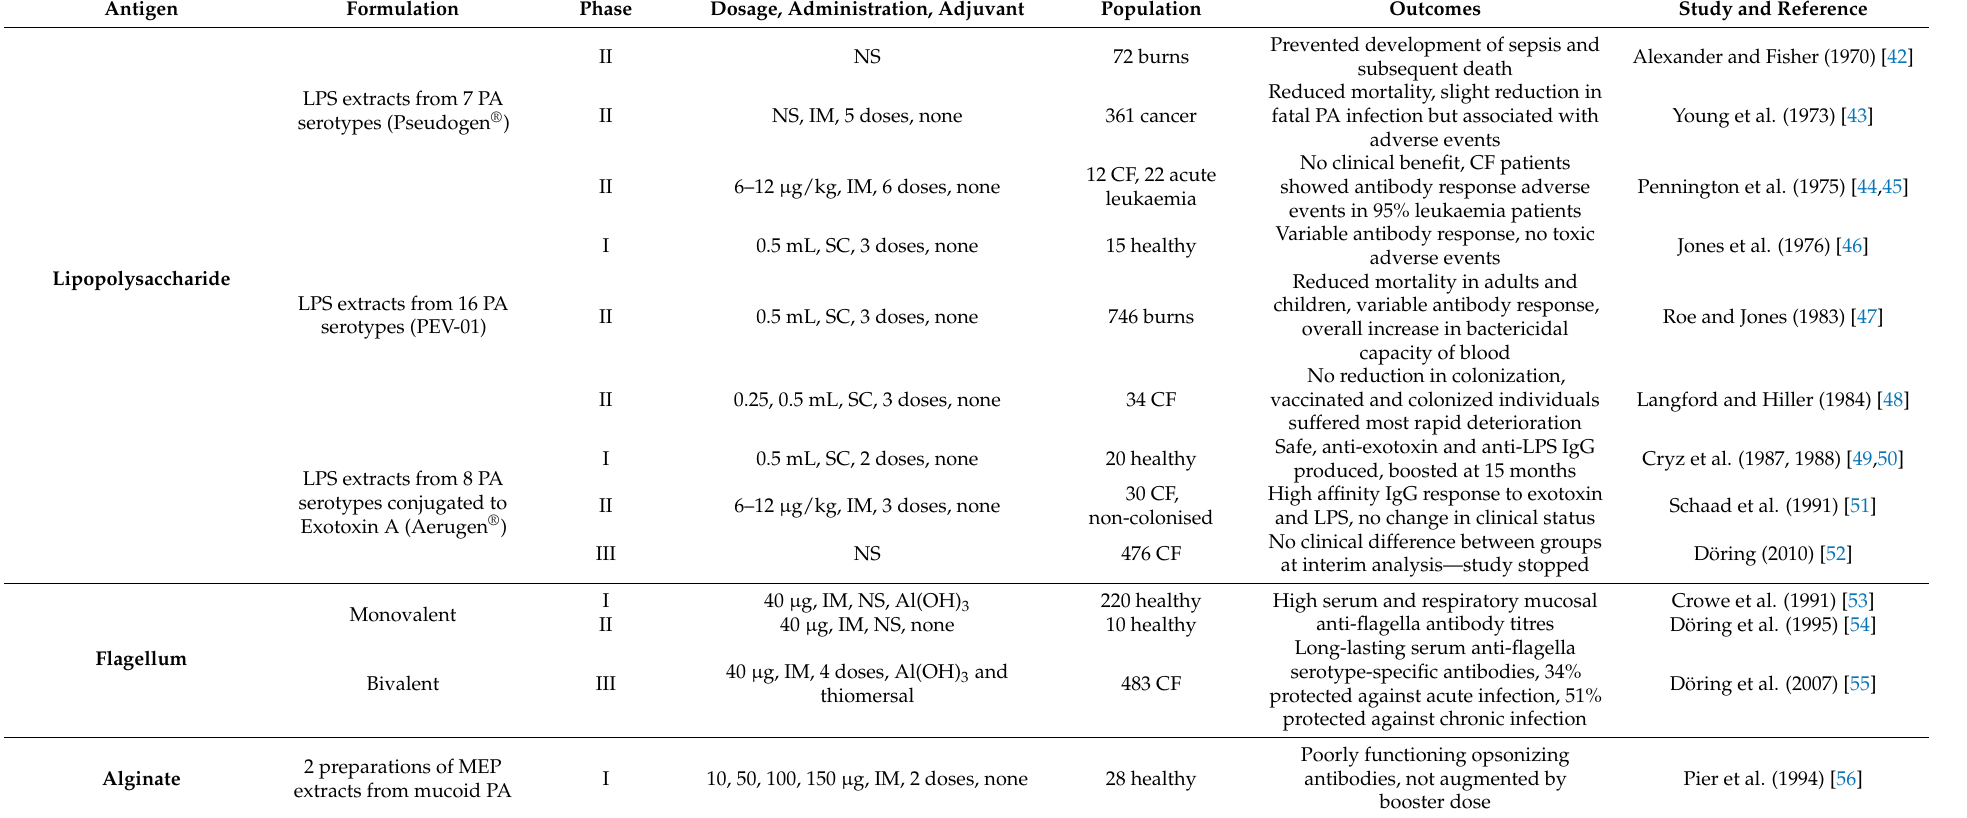
Table 2. A summary of all clinical vaccine trials in P.